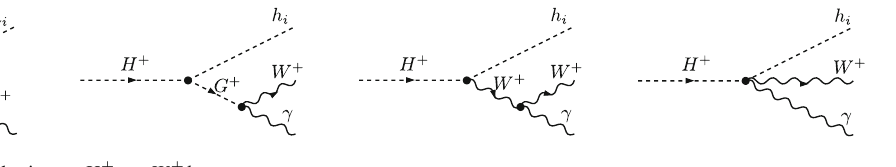
Fig. 3 Feynman diagrams contributing to H ± → W ± h i γ